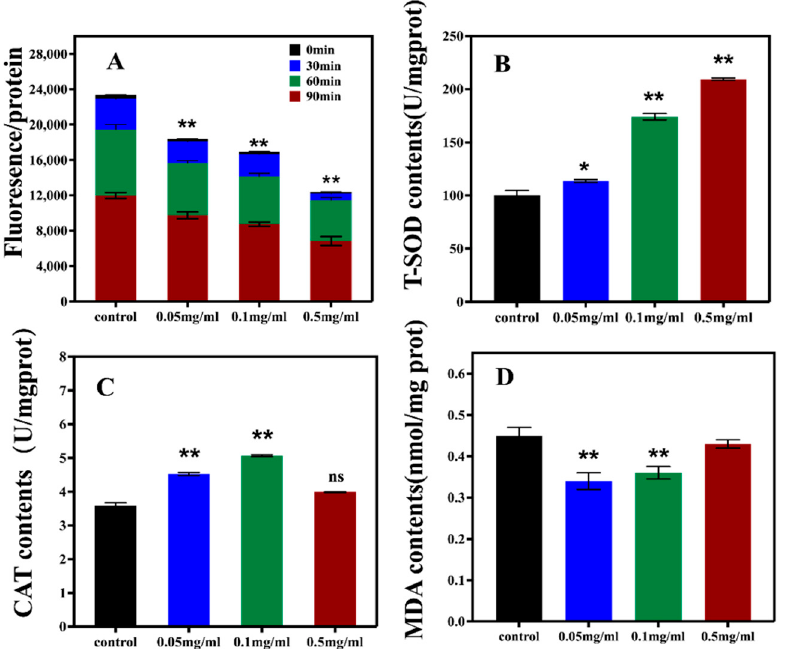
Figure 2. Effect of SPO on ROS ( A ), activity of SOD ( B ) and CAT ( C ), and MDA contents ( D ). All data are expressed as mean ± SD, analyzed with ANOVA with the Dunnett’s comparisons test (post-hoc), relative to control * p < 0.05, ** p < 0.01, ns—no significance.